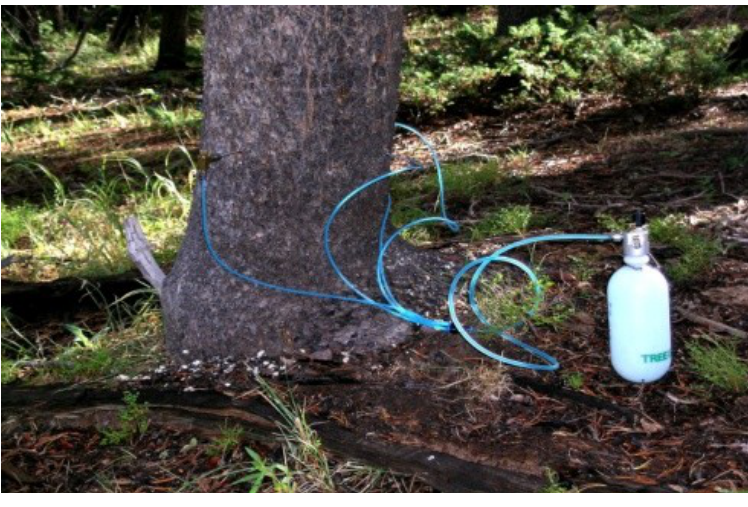
Figure 5. Arborjet Inc. injection treatment used to apply insecticide directly into the tree bole [185] (Photo: A. Steven